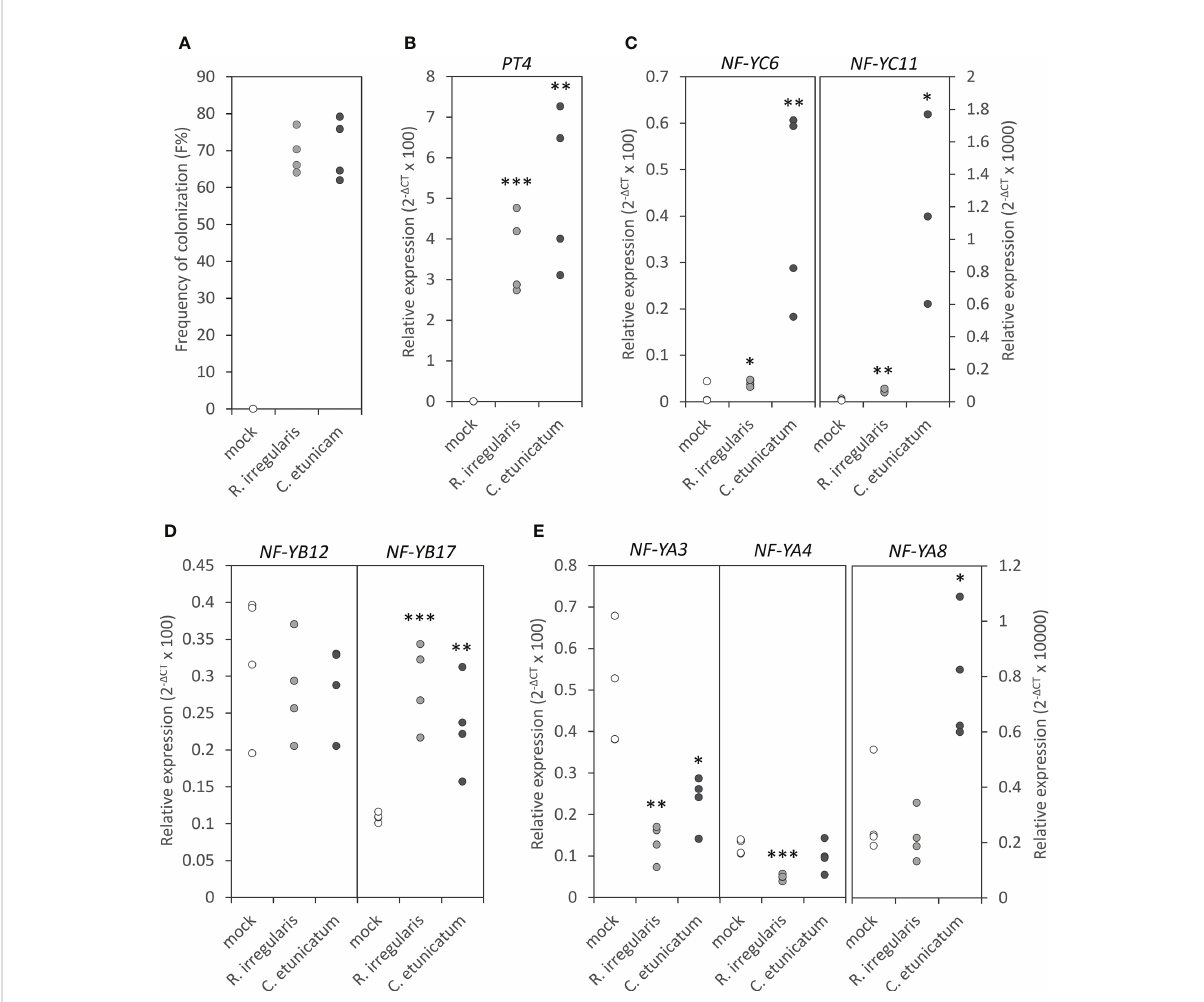
FIGURE 2 The responses of MtNF-YC6 , MtNF-YC11 and their interacting NF-Y subunits to AMS. (A) The frequency of colonization in AMF-colonized roots. (B) The relative expression level of MtPT4 . (C-E) The relative expression level of MtNF-YC6 and C11 (C) , MtNF-YB12 and B17 (D) and MtNF-YA3 , A4 , and A8 (E) in mock- and AMF-treated roots. n=4. Student ’ s t test evaluated the difference between mock- and AMF- treated roots. *p<0.05, **p<0.01,